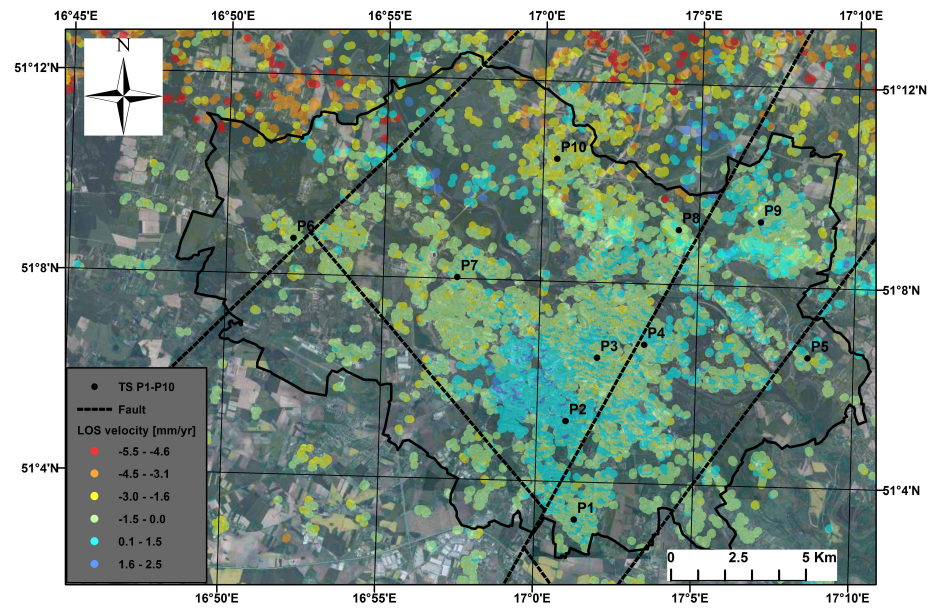
Figure 6. LOS velocities determined on the basis of ERS-2 data for the period 1995–2004. In the next period of 2002–2008, displacements velocities (LOS) determined from the Envisat InSAR stack ranged from − 5.5 mm/year to +0.9 mm/year (Figure 7). Positive displacements were recorded in several places in the northeastern part, while negative displacements occurred on the remaining area.